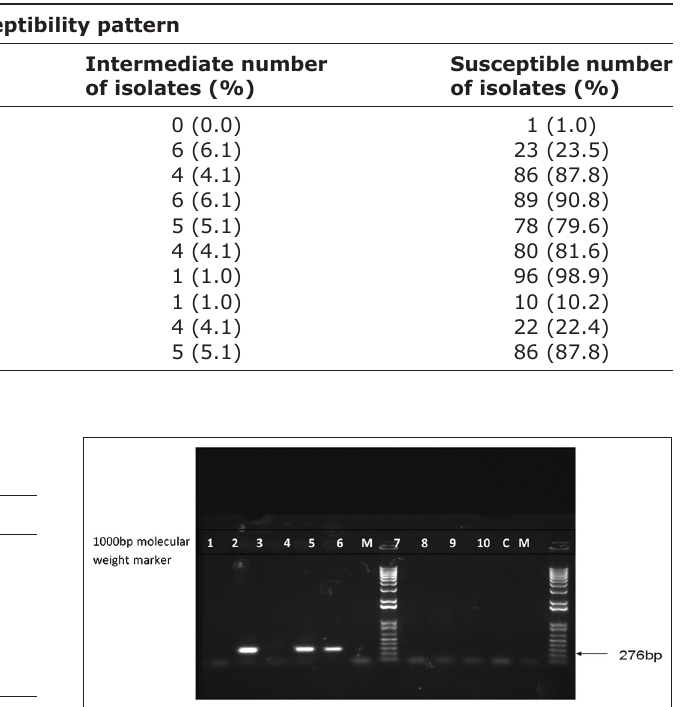
Table-3: Antibiotic susceptibility pattern of MRSA isolated from hunting dogs in Maiduguri metropolitan, Borno State.